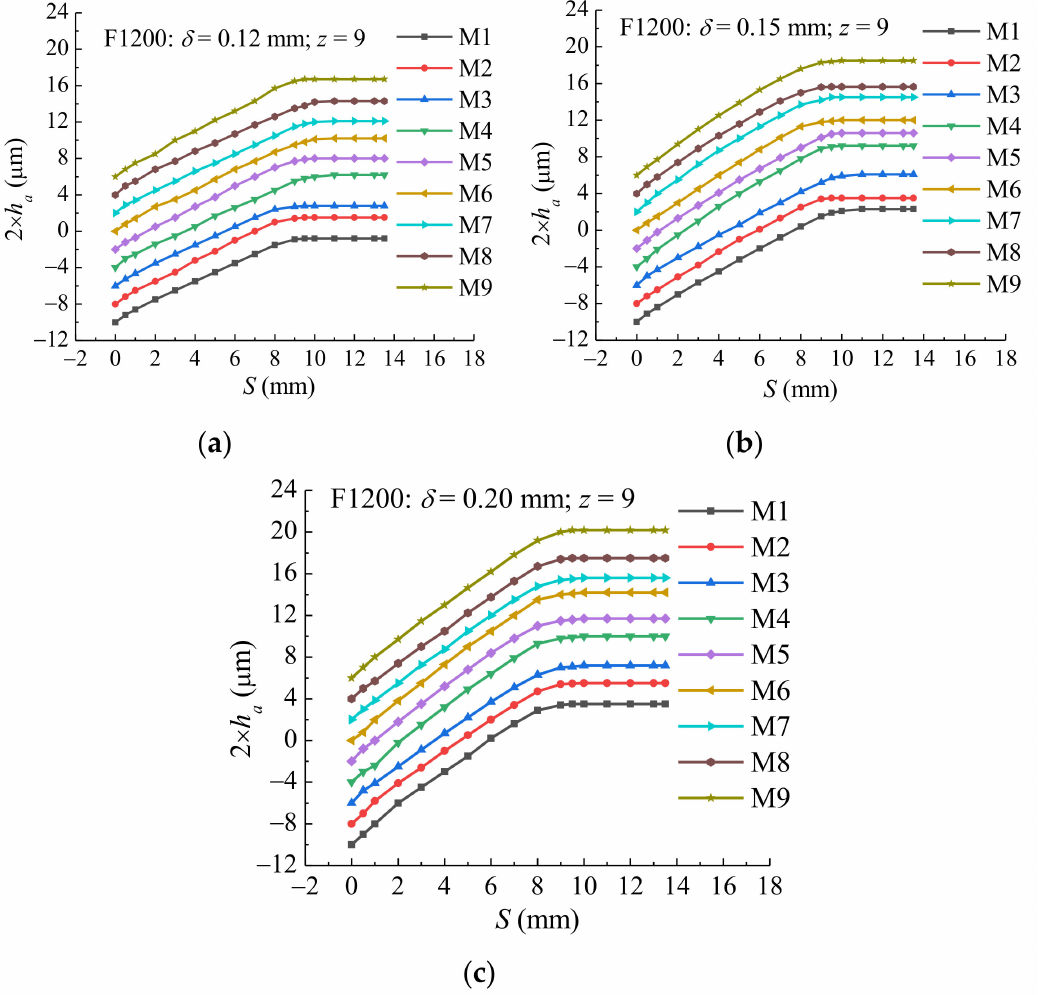
Figure 5. Measurement of the waviness amplitude, including ( a ) δ = 0.12 mm, ( b ) δ = 0.15 mm, ( c ) δ = 0.20